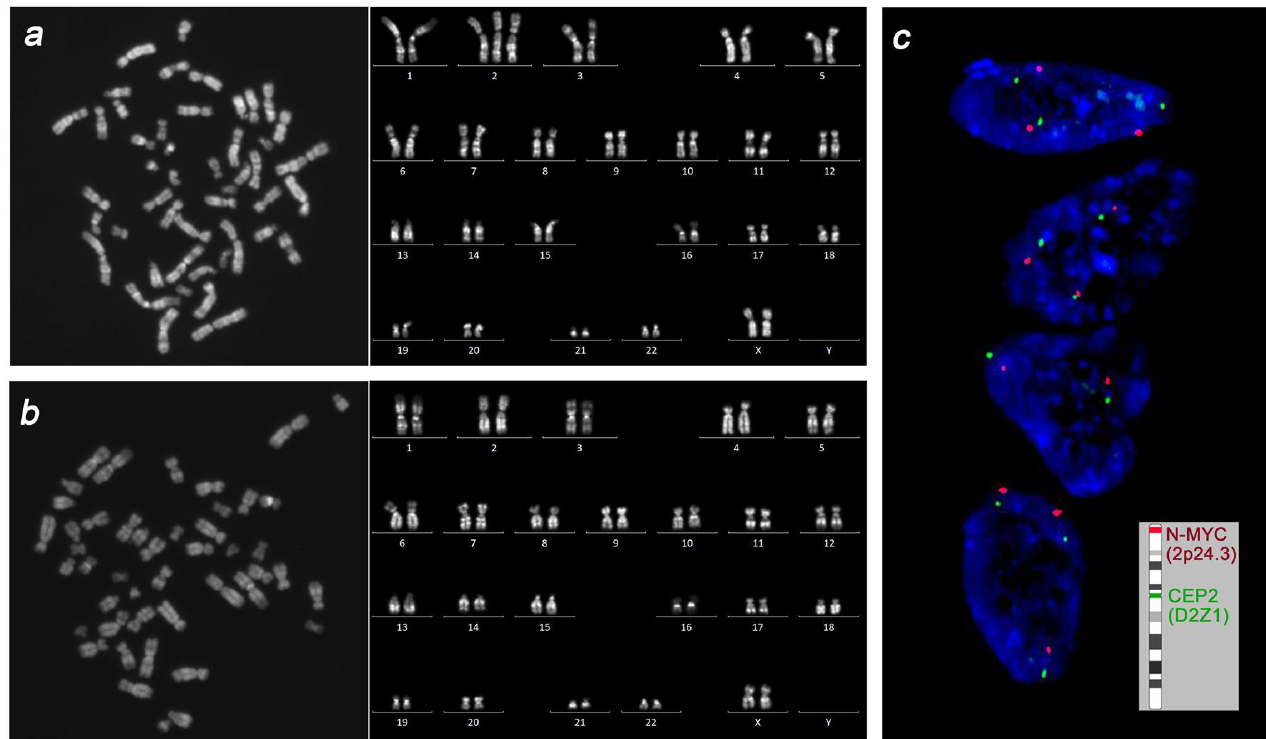
Figure 3. The cytogenetic picture in placenta and fetus. Conventional karyotyping revealed preva- lence of cells with trisomy 2 in placenta ( a ) and normal karyotype in femoral muscle cells ( b ). Interphase FISH for chromosome 2 in uncultured specimens of the placenta and fetal tissues revealed prevalence of trisomic over disomic nuclei in placenta ( c ) and a low-level mosaicism for trisomy 2 in fetal liver, lung, and heart tissue.